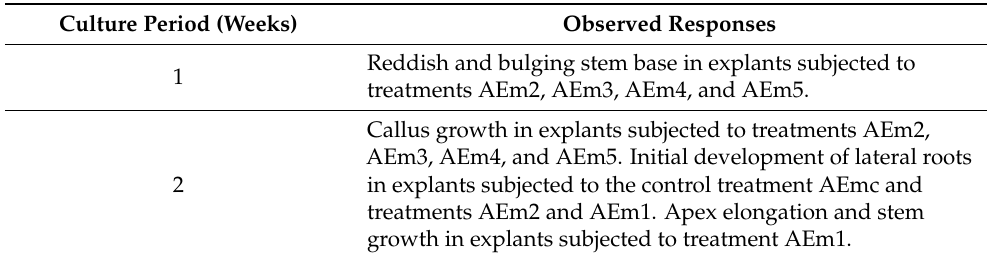
Table 2. Morphogenic responses observed in the culture of initial explants of A. taltalensis subjected to multiplication